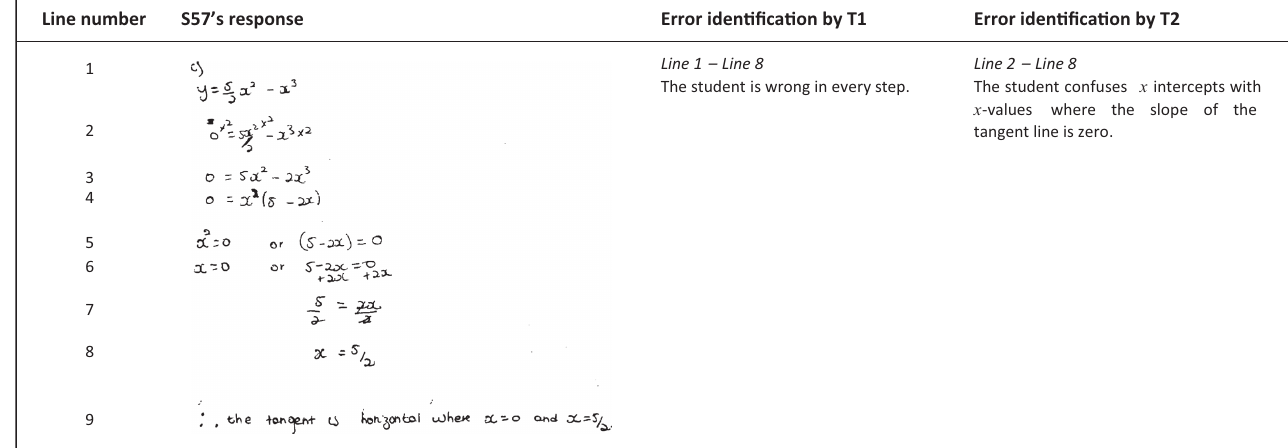
FIGURE 3: Error identification in S57’s response.